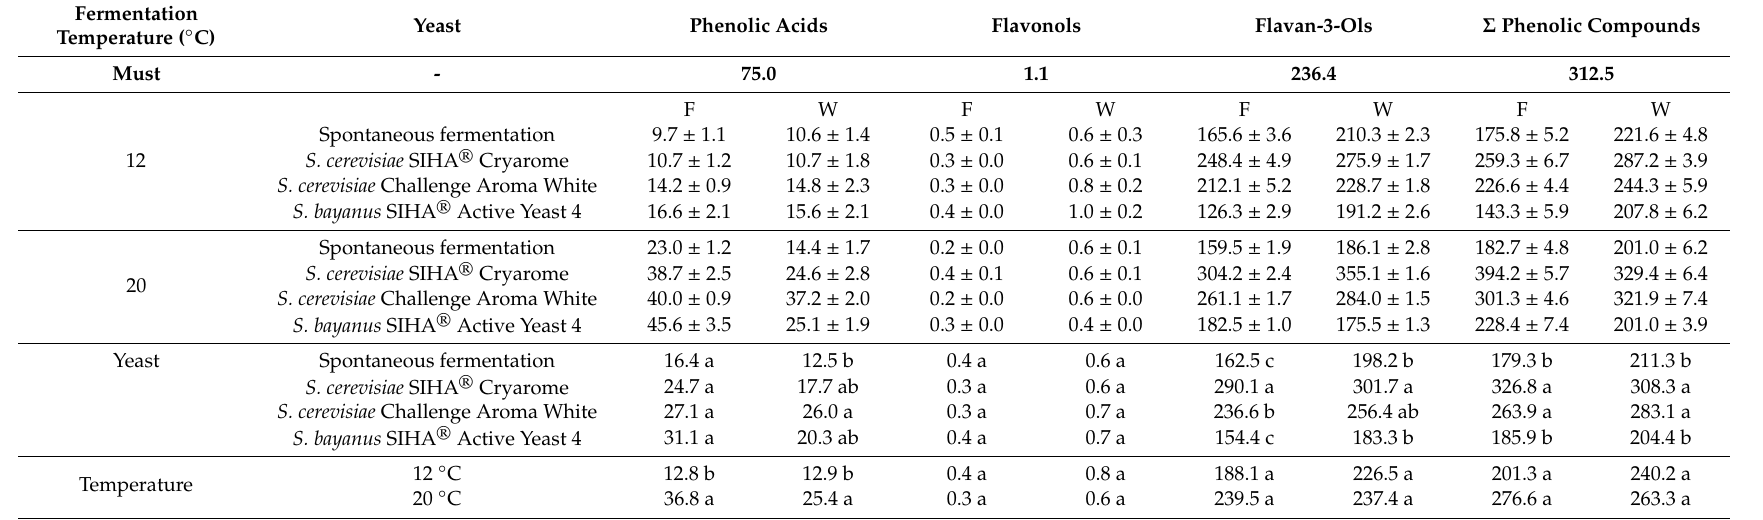
Table 2. Content of phenolic compounds in Aurore must and wine (mg /